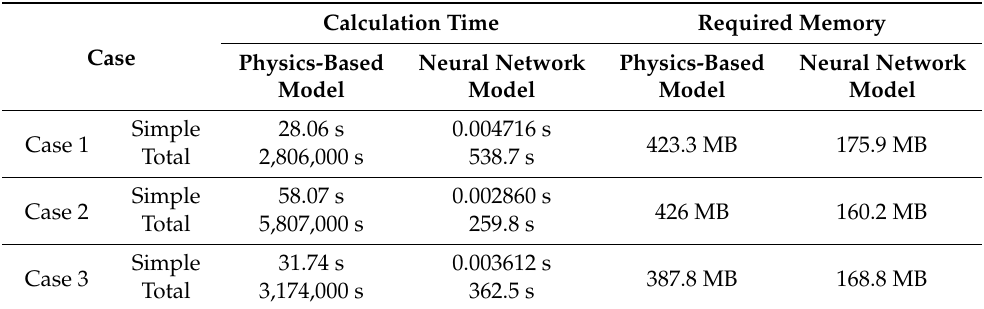
Table 9. Improvement in computational efficiency through artificial neural network model according to the